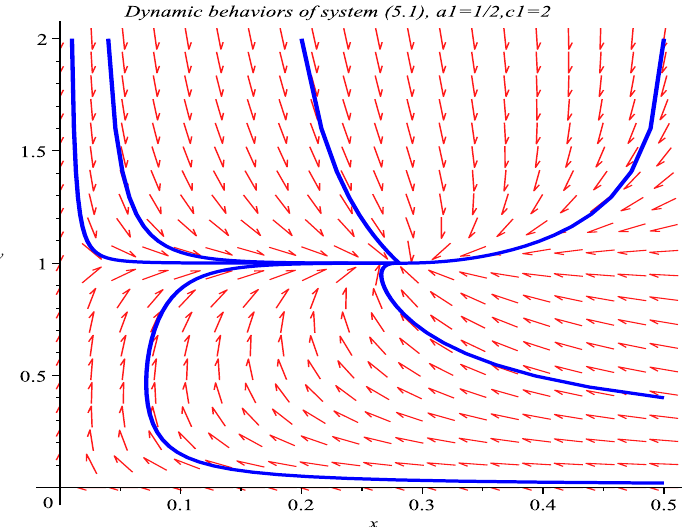
, c 1 = 2, which includes the 2